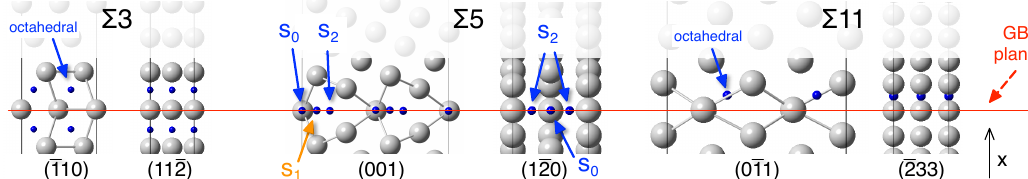
Figure 4. Details of the grain boundary configuration with indicated positions of the preferred segregation sites for hydrogen atoms. S 0 and S 2 are the preferred segregation positions found in the FP-MD simulations, and S 1 is another position considered in Reference